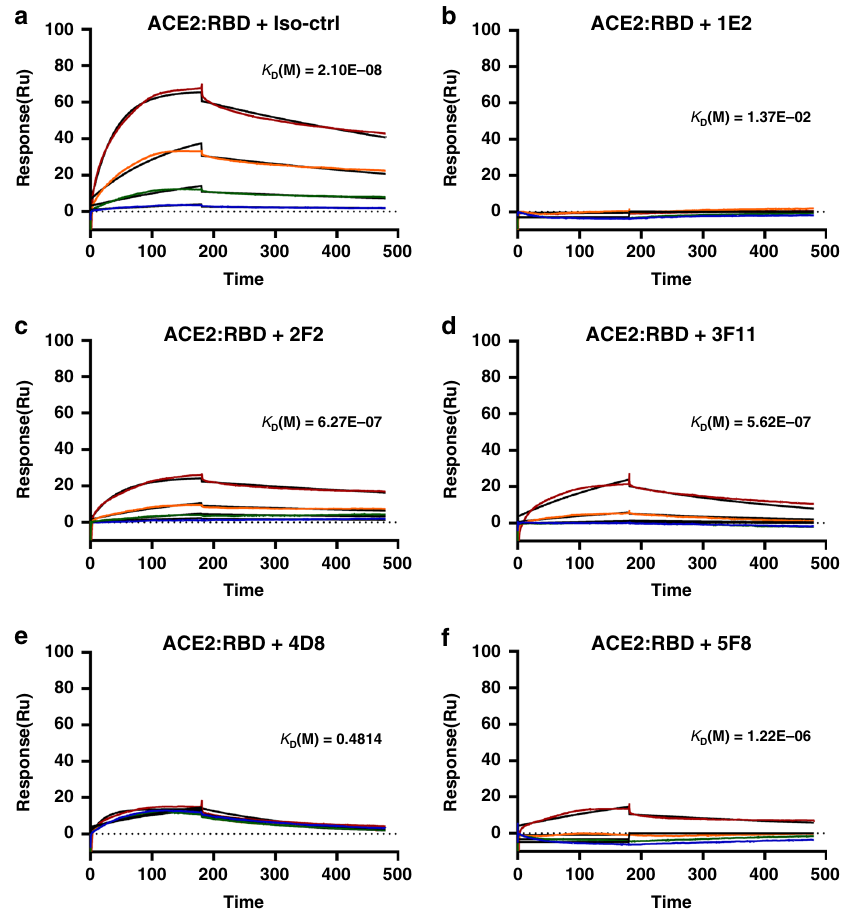
Fig. 3 Interference of the ACE2-RBD interaction by the sdAbs. The recombinant human ACE2 protein was immobilized on CM5 chip using a BIAcore T200 machine and tested for the binding with gradient concentrations of SARS-CoV-2 RBD that were diluted in 100 nM sdAbs, including an isotype control sdAb ( a ), 1E2 ( b ), 2F2 ( c ), 3F11 ( d ), 4D8 ( e ), and 5F8 ( f in phagemid vector fADL-1 (Antibody Design Labs, San Diego, CA, USA) using S fi I/BglI sites with the PelB peptide leader sequence fused with the sdAbs at N- terminus. The ligation product was puri fi ed and used to transform electro- competent E. coli TG1 cells. A total 50 electroporations was performed in the condition of 1800 V, 10 mF, 600 W. Each electroporation was resuspended with 2 ×YT and incubated with a shaking agitation for 1 h at 37 °C, and then combined and plated onto more than a thousand agar petri dishes (140mm) to ensure enough size of the library. Library size was calculated by plating serial dilution aliquots and at least 1.2× 10 10 individual recombinant clones were obtained. Quality control was carried out by sequencing more than 1000 clones. More than 950 clones are full length and unique sdAbs and less than 50 clones show various errors, such as vector self-ligation, reading frame shift and fragment deletion. Antibody selection by phage display . Screening for SARS-CoV-2 RBD targeting antibodies was performed by panning in both immunotubes and native condition using a proprietary full-synthetic library of humanized sdAbs with high-diversity, according to a standard protocol. Brie fl y, for the 2nd and 4th panning rounds, the puri fi ed SARS-CoV-2 RBD protein fused with mouse Fc was coated on Nunc MaxiSorp immuno tubes (ThermoFisher) at around 5µg/mL in PBS overnight. For the 1st and 3rd panning rounds, RBD protein was fi rst biotinylated with EZ-Link ™ Sulfo-NHS-LC-Biotin (ThermoFisher) and then selected with streptavidin-coated magnetic Dynabeads ™ M-280 (ThermoFisher). The tubes or beads were blocked using 2% w/v skimmed milk powder in PBS (MPBS). After rinsing with PBS, about 1× 10 13 phage particles were added to the antigen-coated immuno tube or bioti- nylated antigen in the presence of 2% MPBS, incubated for 2 h shaking (30 rpm) at RT. Unbound phages were washed with PBS Tween 0.1% (10 times) and PBS (10 times), while bound phage were eluted with 0.1M Glycine-HCl (pH = 3.0). Eluted phages were neutralized by adding 1M Tris-Cl pH 9.0 and used for infection of exponentially growing E. coli TG1. After 4 rounds of panning, phage ELISA identi fi cation was performed with 480 individual colonies using Anti-CM13 anti- body [B62-FE2] (HRP) in the plates coated with either mouse Fc-fused SARS-CoV- 2 RBD or mouse Fc as a negative control for screening. The absorbance was